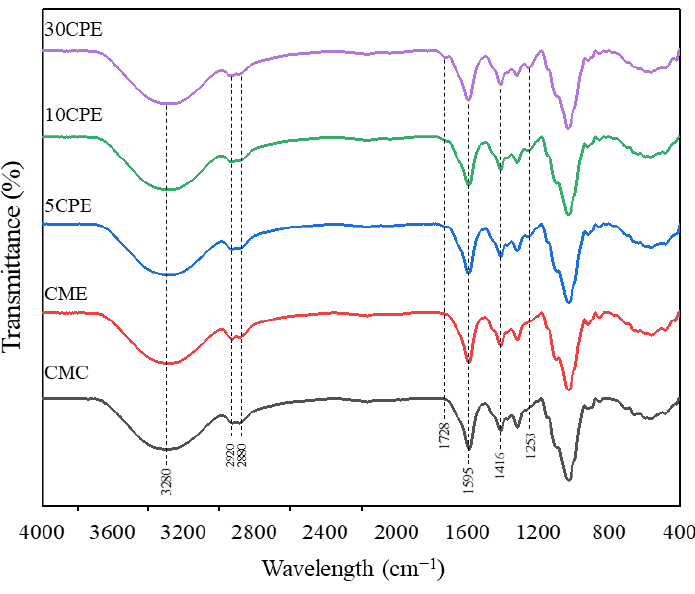
Figure 2. FT-IR spectra of composite OLP/CMC films.